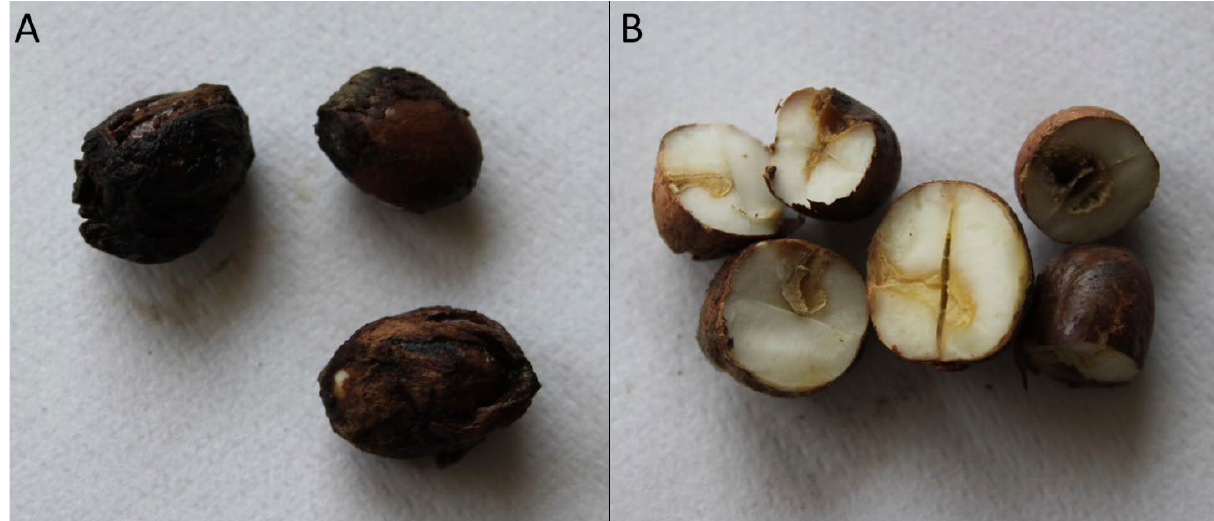
Figure 5. A, Necrotic spots on hazelnut kernel surfaces developed after artificial inoculation with Diaporthe spp. and incuba- tion at 20°C for 21 d. B. Internal browning observed in cut kernels that were slightly damaged before artificial